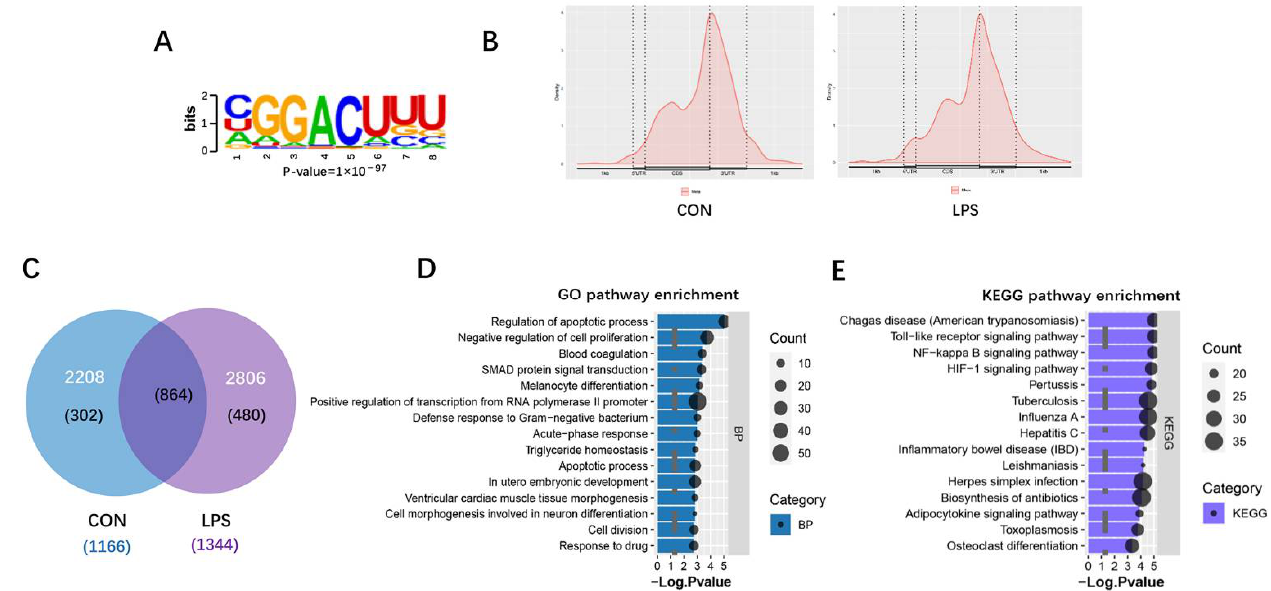
Figure 4. MeRIP-seq of transcriptome in the liver of CON and LPS groups. ( A ) Consensus m 6 A motif of the LPS group, as assessed by MEME. ( B ) Metagene profiles of m 6 A peaks across mRNA transcriptome. ( C ) Venn plot showed the differentially expressed m 6 A peaks and relevant genes in the CON and LPS groups. ( D , E ) The top 15 GO and KEEG enrichment analyses of m 6 A-modified genes in the LPS